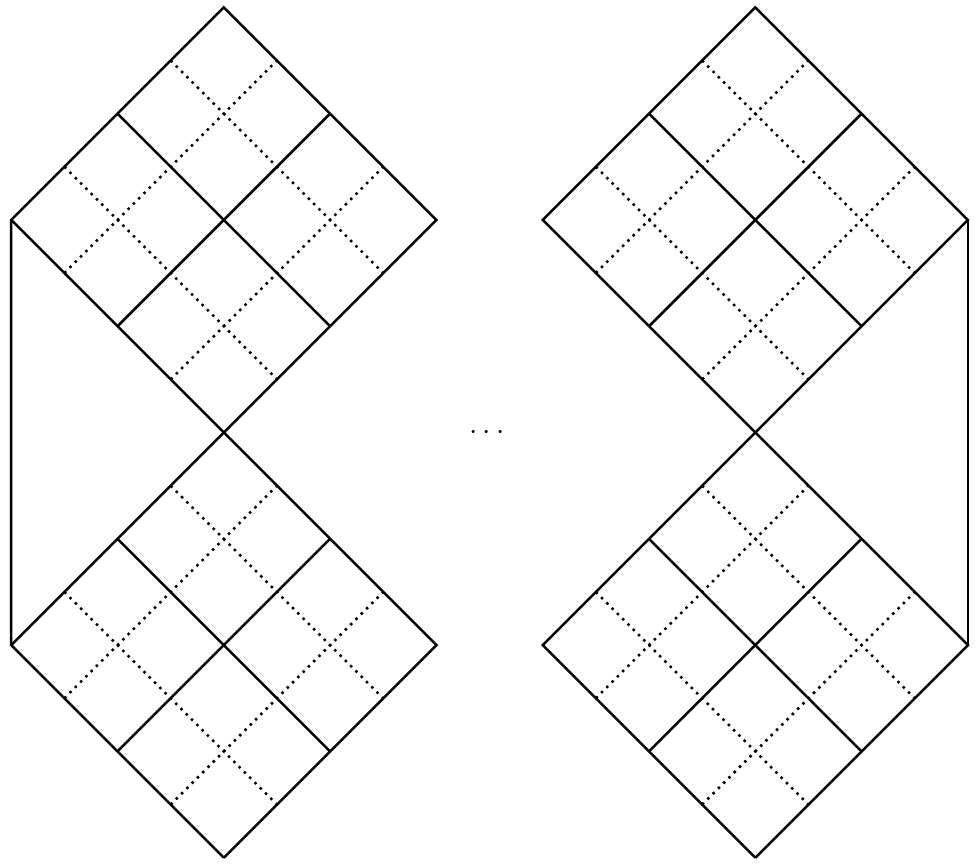
edges, shown as 2